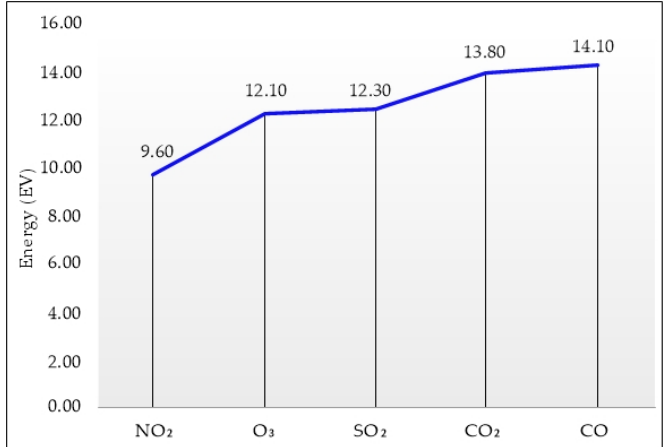
Buildings 2023 , 13 , x FOR PEER REVIEW Figure 3. Ionization energy adapted from Manuel and Moreno, 2015. Figure 3. Ionization energy adapted from Manuel and Moreno, 2015.